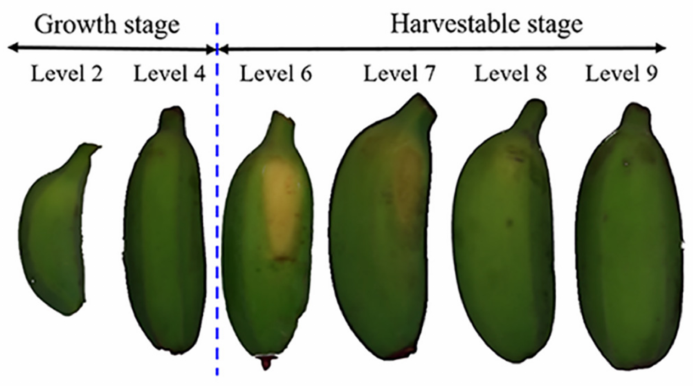
Figure 1. Pseudo-color image of banana fingers in the six maturity levels.